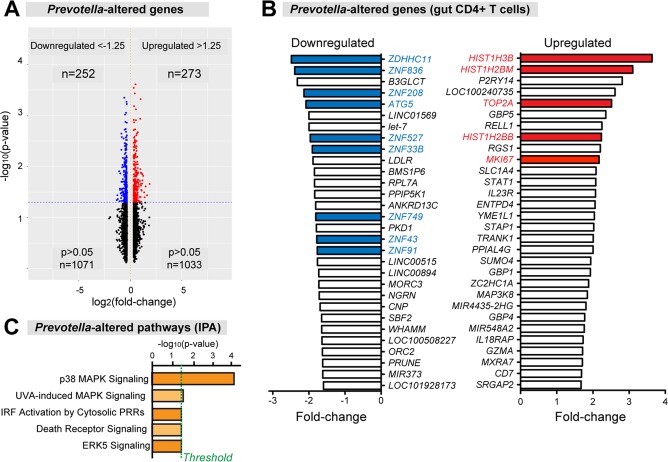
Microbial exposure alters gut CD4+ T cell gene expression.HIV-1-uninfected LPMCs were exposed to mock (media) or Prevotella stercorea (2.5 bacteria: 1 LPMC) for 4 days, and sorted gut CD4+ T cells were subjected to microarray analyses. (A) Volcano plots showing differentially regulated genes following microbial exposure. (B) Top 30 ranked down- and upregulated genes in microbe-exposed CD4+ T cells. Colored bars correspond to genes discussed in the text. (C) Ingenuity Pathway Analysis. The pathway with the highest Z-score and p-value is the p38 MAPK pathway.